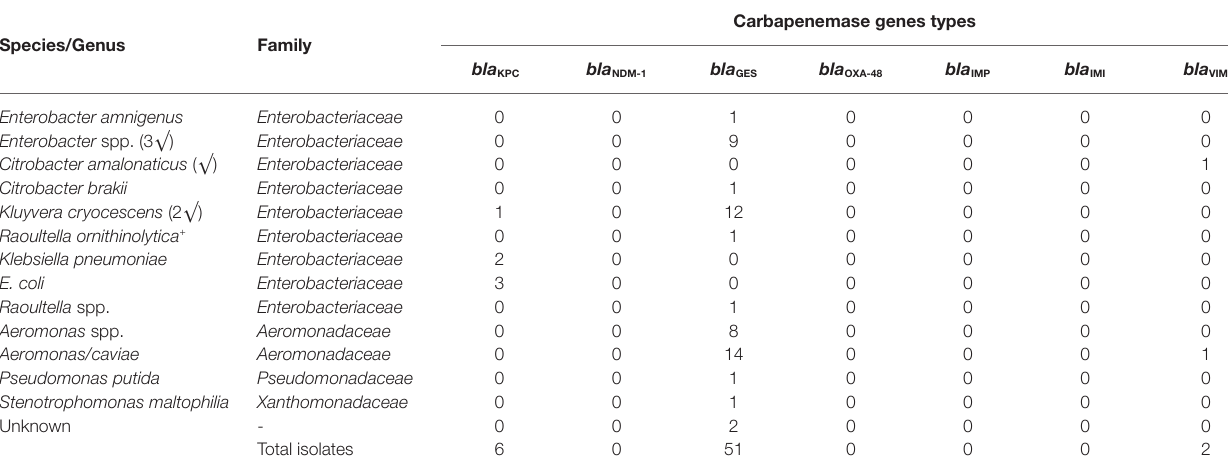
TABLE 2 | Gram-negative bacterial isolates carrying various bla CARBA genes screened from a total of 399 isolates obtained from CHROMagar extended-spectrum beta- lactamase (ESBL) and CHROMagar Klebsiella pneumoniae carbapenemase (KPC) media.